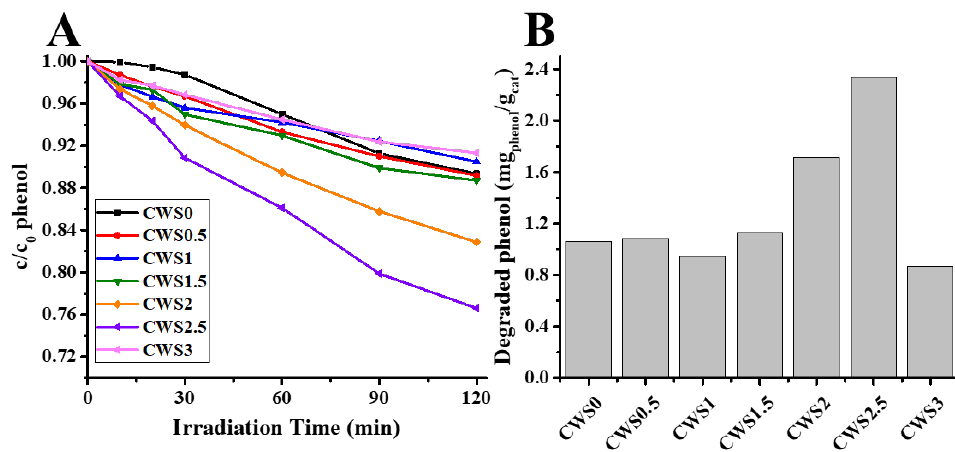
Figure 6. Run of decay curves, photocatalytic activity of the CWSX photocatalysts and reference SrTiO 3 (CWS0) ( A ) and the exact amount of phenol that has been destroyed (mg phenol /g cat ) ( B ).